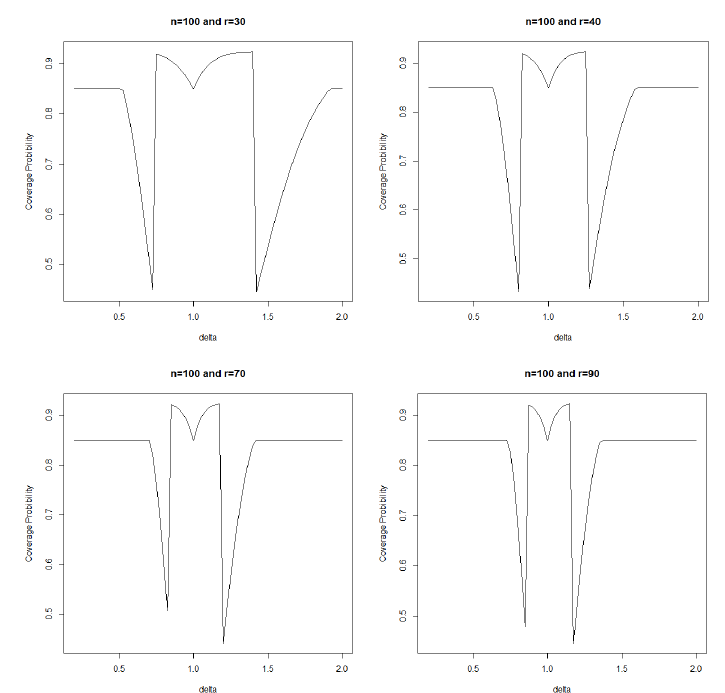
Figure 1 – Coverage probability of PTCI of σ plotted as a function of